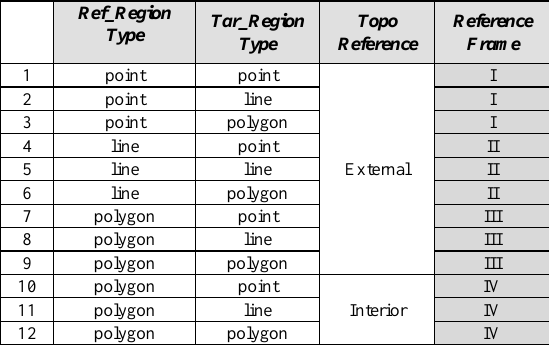
Table 1. Composition of query